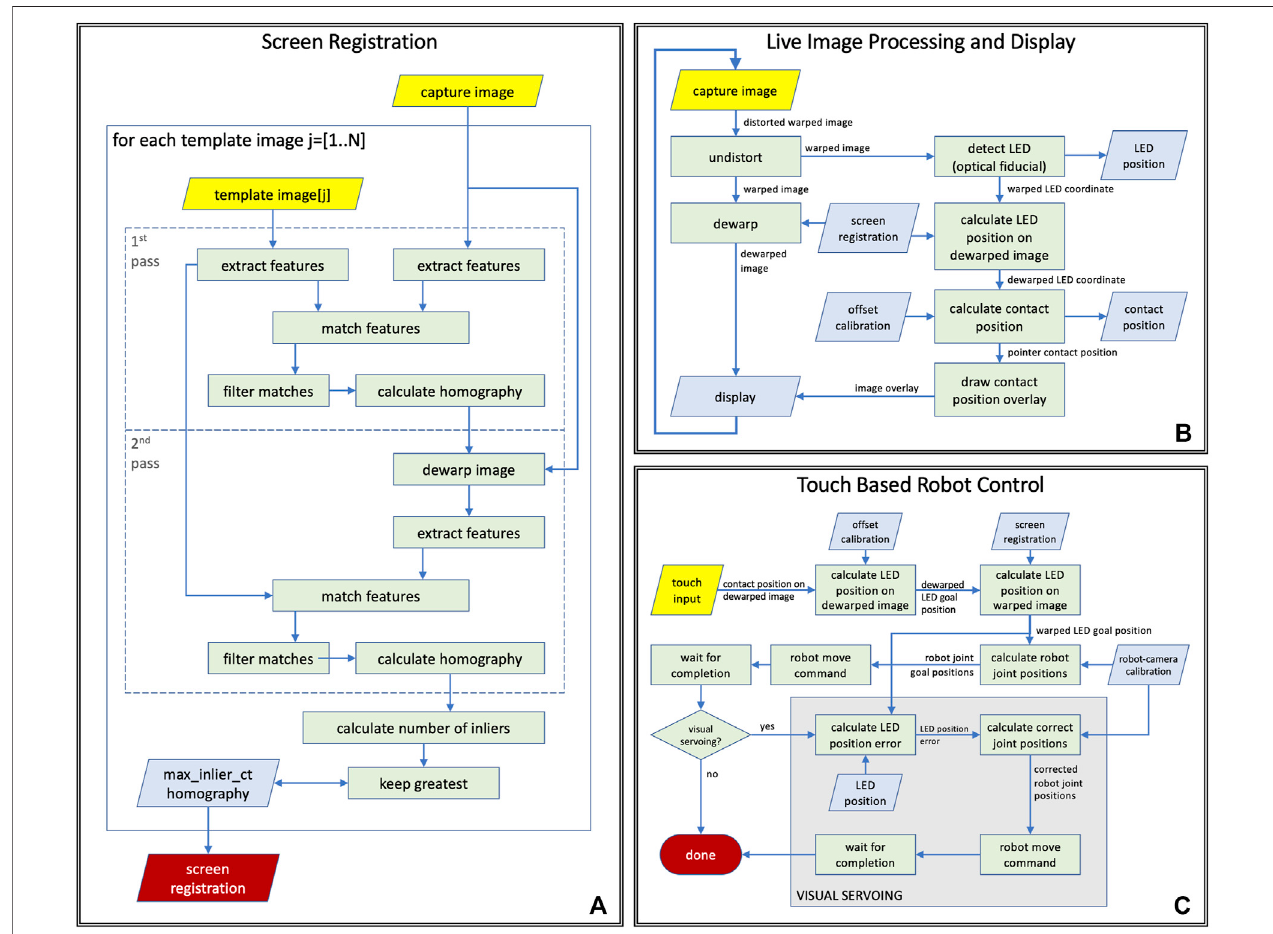
FIGURE 4 | Computer vision tasks performed during (A) ventilator screen registration, (B) live teleoperation, (C) touch based robot control logic with and without visual servoing.